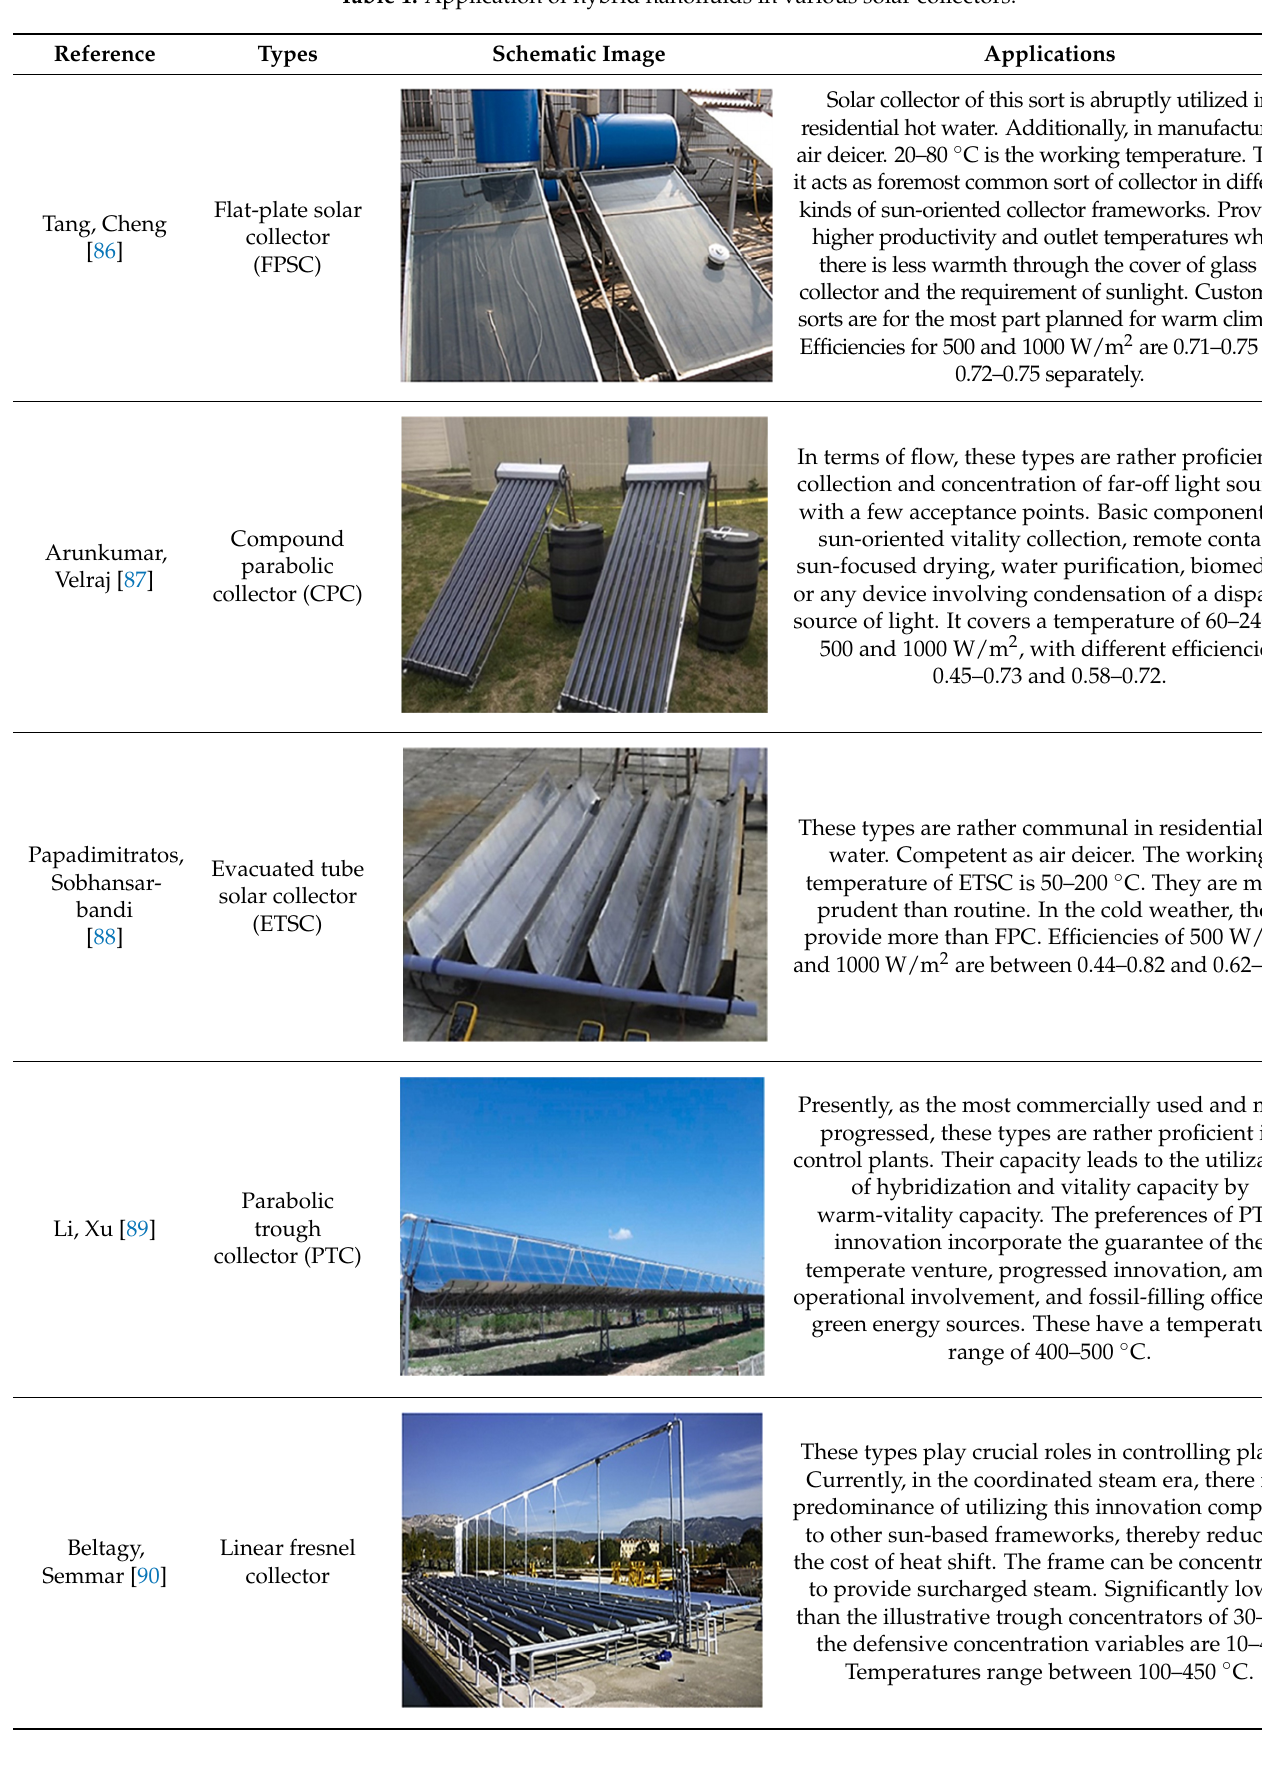
Table 1. Application of hybrid nanofluids in various solar collectors.